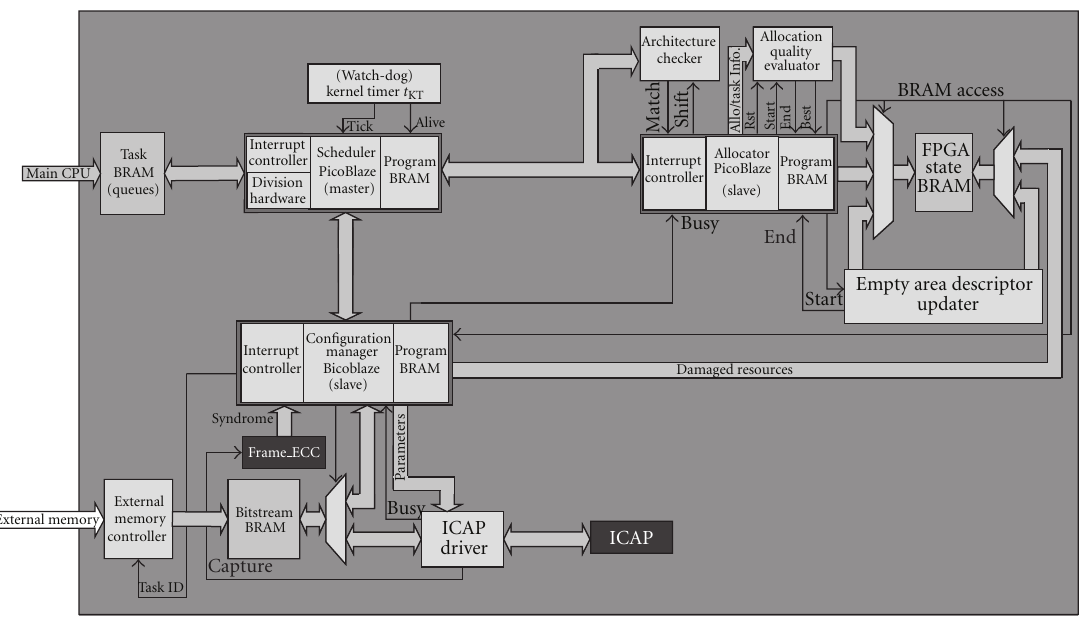
Figure 19: Overview of R3TOS